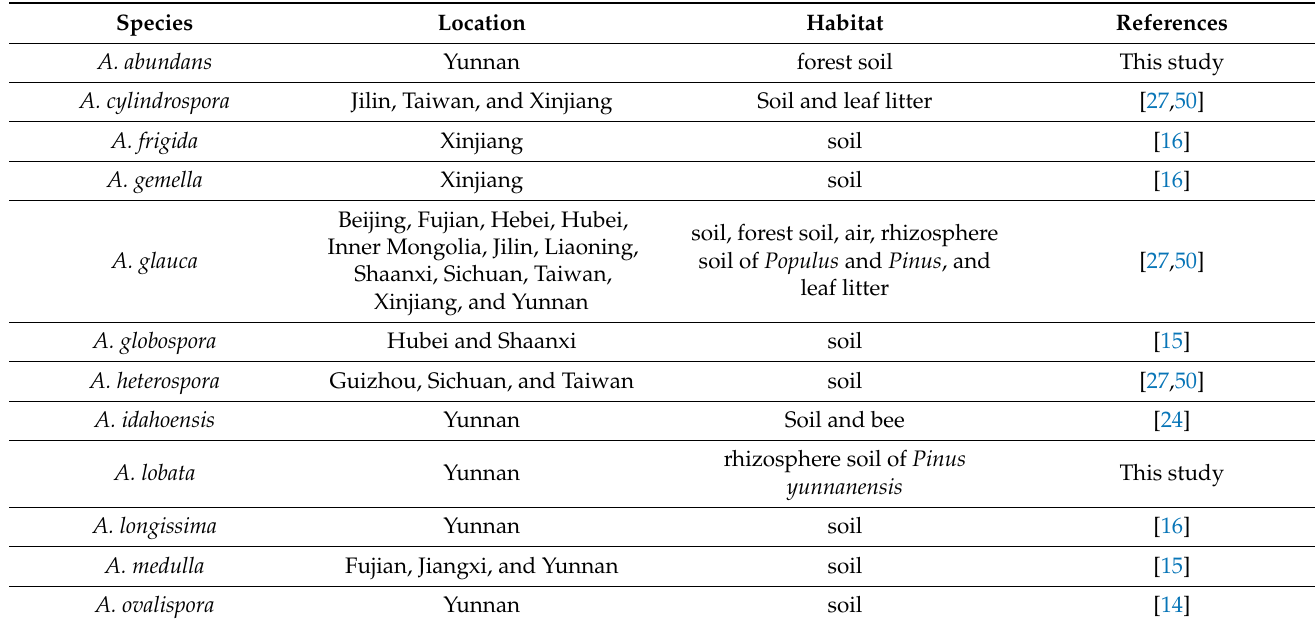
Table 3. Absidia species distributions and ecological habitat in